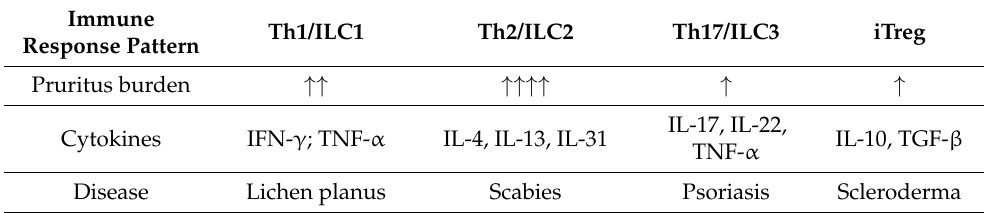
Table 2. Classification of common itchy skin conditions according to the clinical burden of pruritus and the underlying immune-response patterns